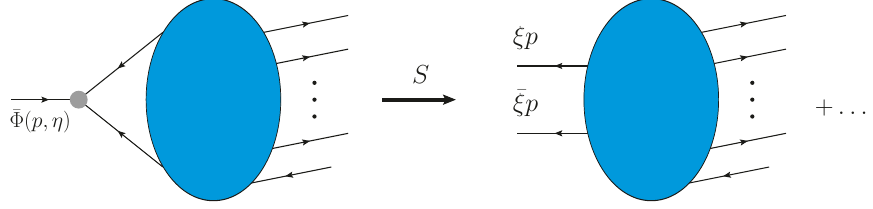
Figure 3 . The S -variation of a multi-loop supergraph is governed by the anomaly of the antichiral vertex function (3.27). We show explicitly only the contribution of one vertex, and also we omit the integration over (cid:24)